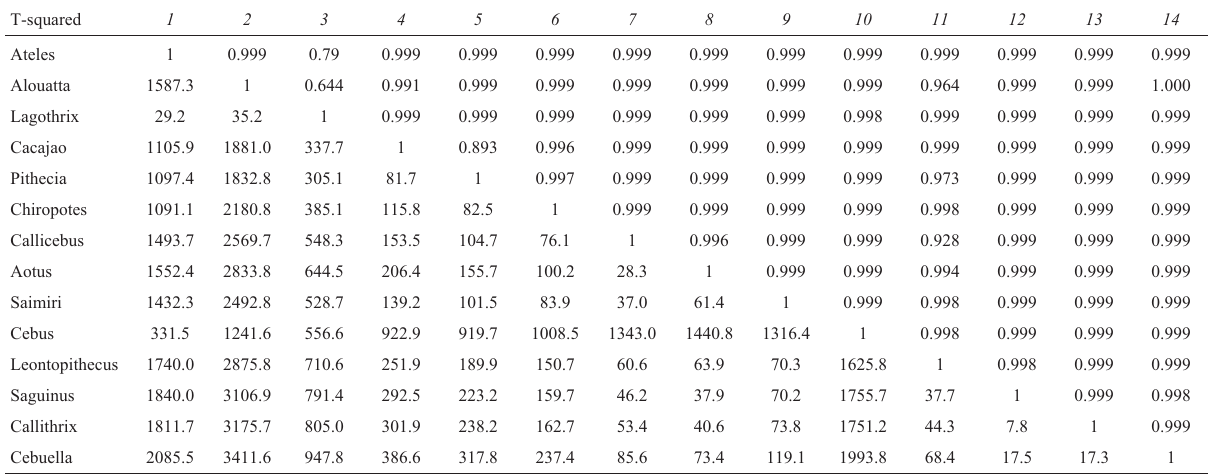
Table5 -T 2 -statisticsresultsareshow.BelowthediagonaltheobservedT 2 valuesandabovethediagonalcorrespondingprobabilitiesthattheelementsof the two matrices does not differ